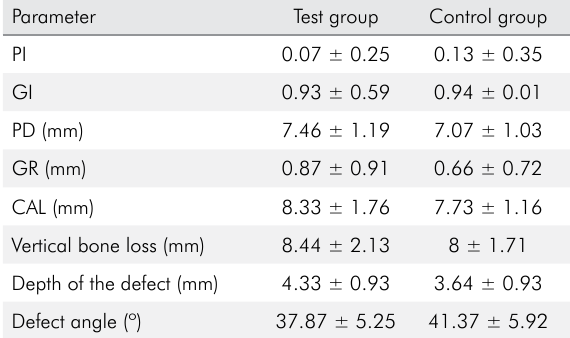
Table 2. Baseline clinical and radiographical